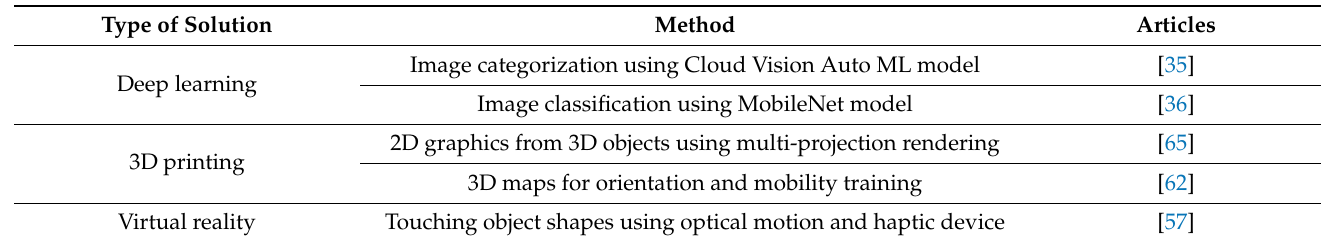
Table 8. AI- and 3D printing-based